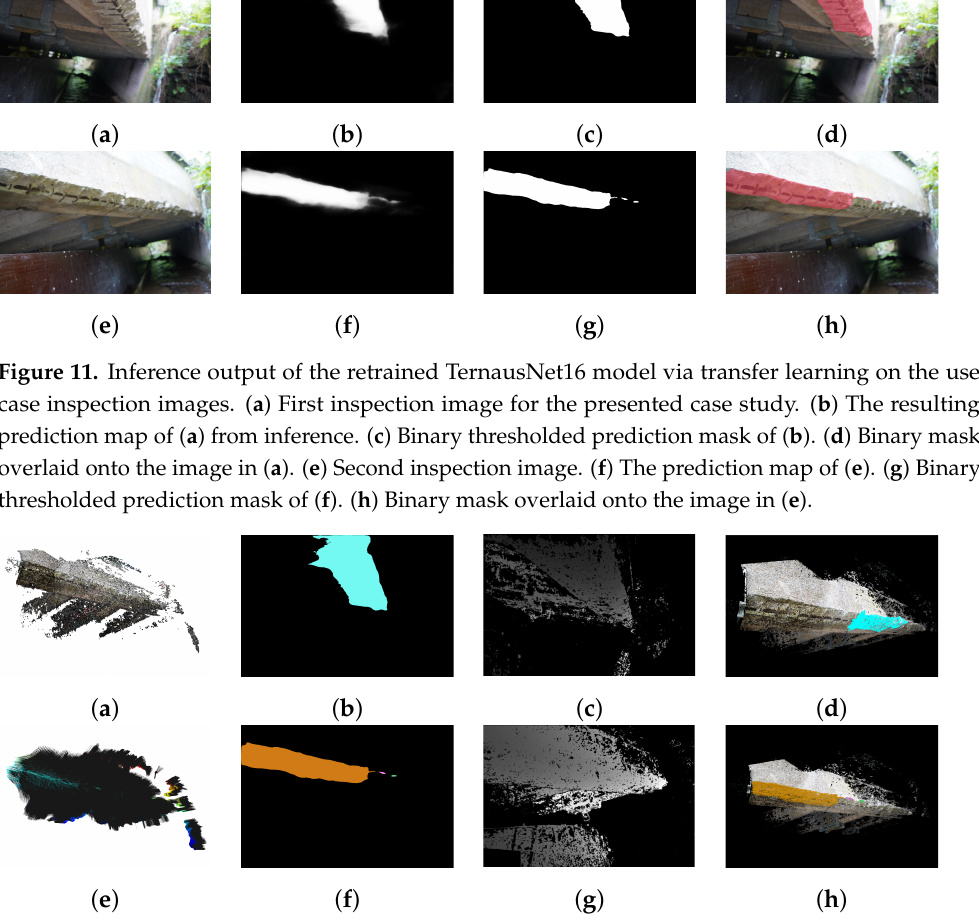
Figure 12. The process of backwards projection of specific pixels into 3D space. ( a ) The 3D recon- structed point cloud. ( b ) Labeled binary map of Figure 11c. ( c ) The estimated depth map of the photo in Figure 11a. ( d ) The back projected labelled points from ( b ). ( e ) The conformed normals of the vertices in the point cloud pointing towards the camera. ( f ) Labeled binary map of Figure 11c. ( g ) The estimated depth map of the photo in Figure 11a. ( h ) The back projected labeled points from ( f